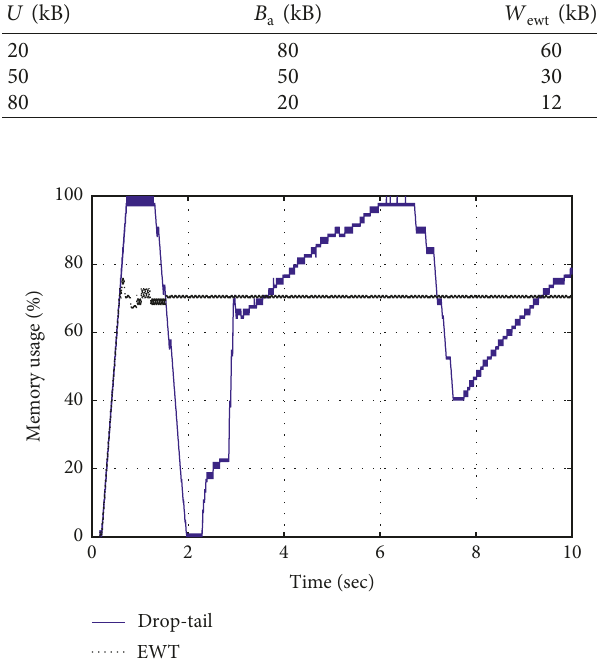
Figure 3: Memory usage of the gateway with drop-tail and EWT.